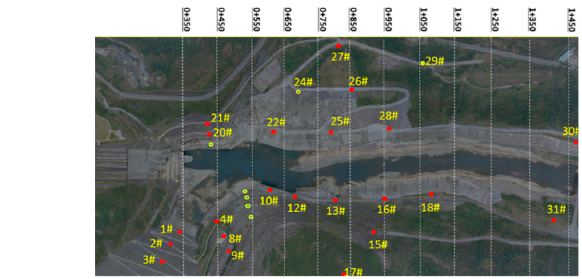
Figure 11. Stable atomization wind speed under different geometric scale conditions.